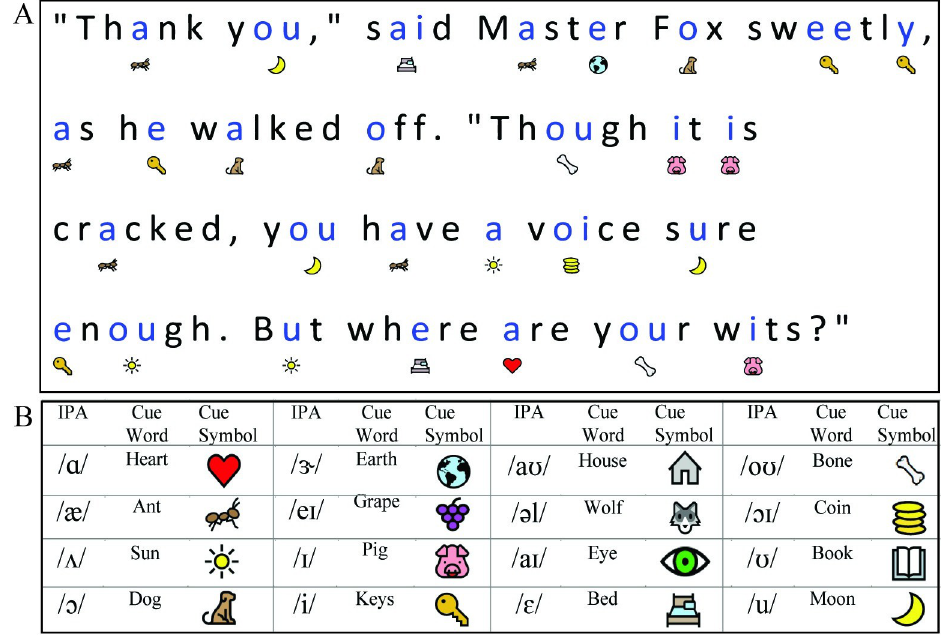
Fig 1. Sound It Out example text. The vowels in this excerpt from Aesop’s ‘The Fox and the Crow” fable appear blue with phonemic image cues provided below. The name of the symbols cues the reader to the sound of the target vowel. Reprinted under a CC BY license, with permission from Microsoft Corporation, original copyright